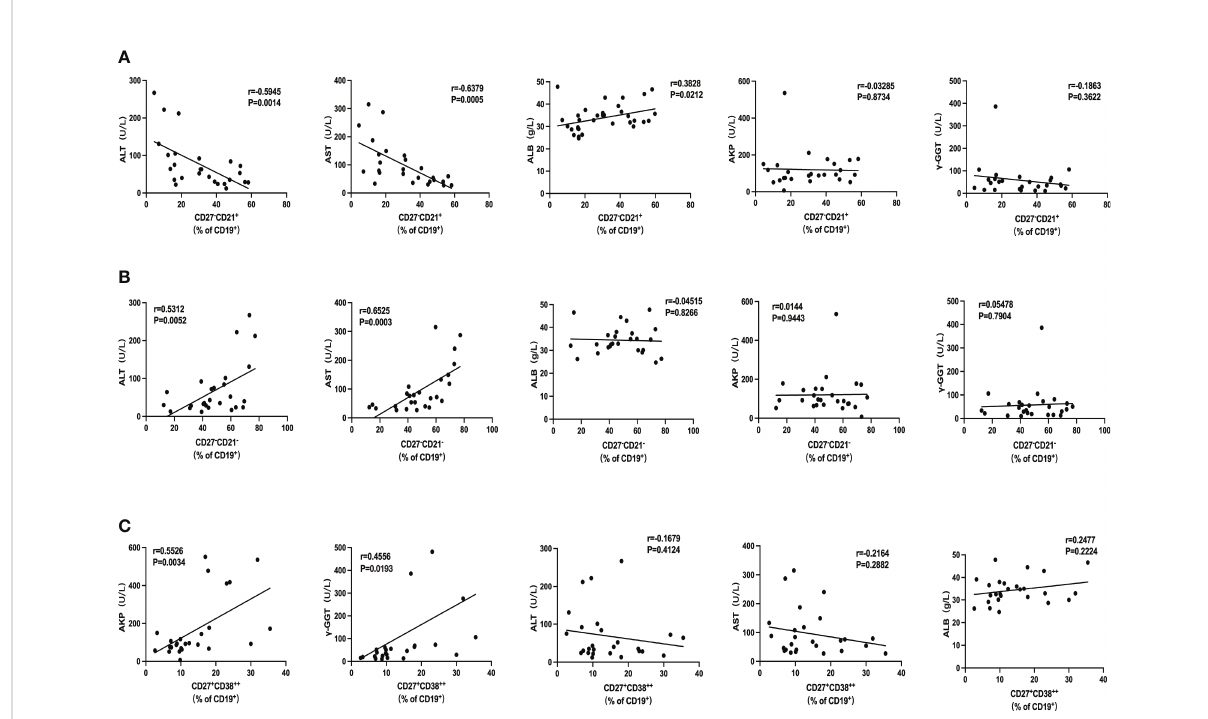
FIGURE 5 The association of intrahepatic B cells subsets with clinical parameters in patients with ACLF. (A) Correlations between the percentage of CD27 − CD21 + CD19 + B cells and ALT, AST, AKP, g -GGT, and ALB of patients with ACLF. (B) Correlations between the percentage of CD27 − CD21 − CD19 + B cells and ALT, AST, AKP, g -GGT, and ALB of patients with ACLF. (C) Correlations between the percentage of CD27 + CD38 + + CD19 + B cells and ALT, AST, AKP, g -GGT, and ALB of patients with